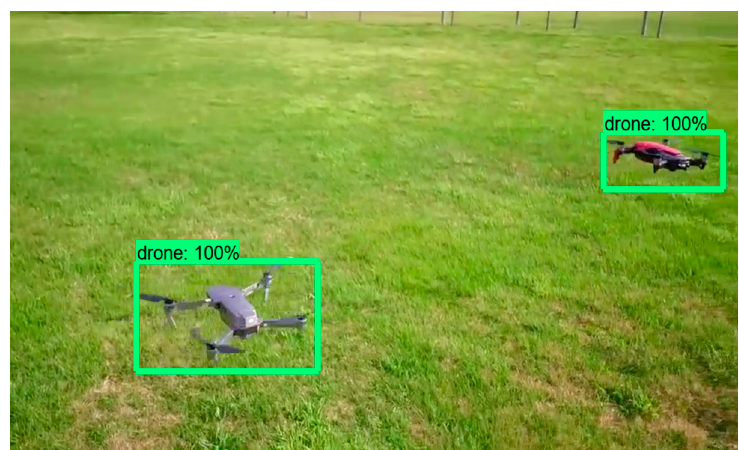
Figure 21. Testing of multiple drones in the scene scenario.